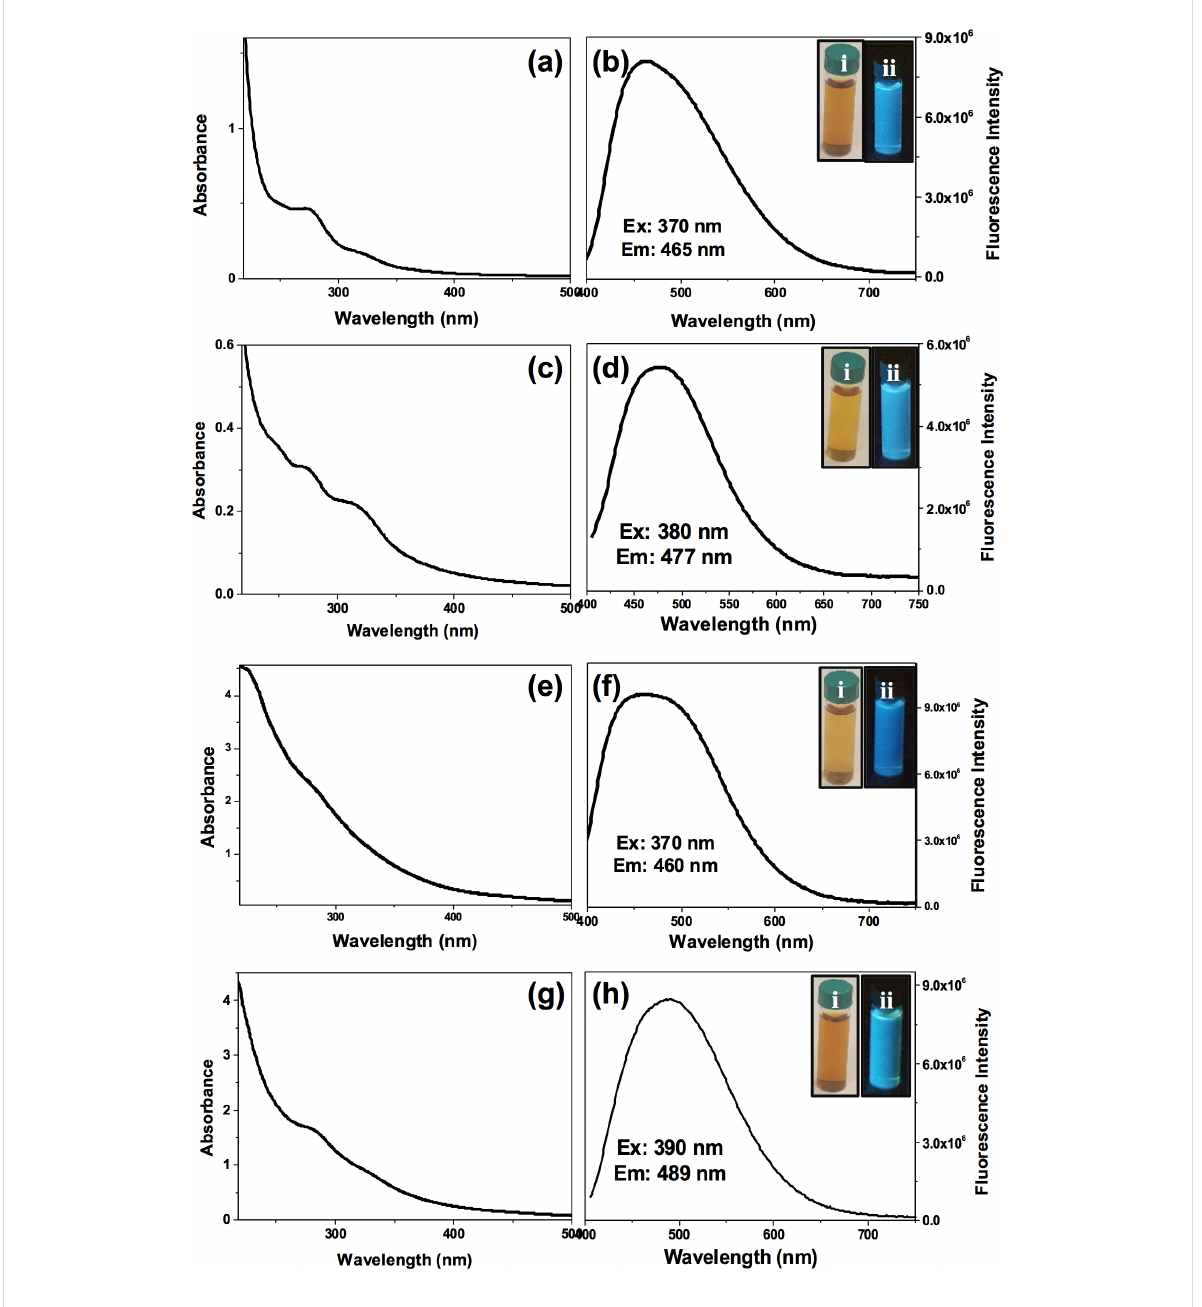
Figure 1: UV–vis absorption and emission spectra of (a, b) cinnamon C-dots, (c, d) red chilli C-dots, (e, f) turmeric C-dots and (g, h) black pepper C-dots (g, h) with their optimum excitation and emission wavelenghts. Insets: Photographs of the corresponding C-dots (i) day light and (ii) UV light.